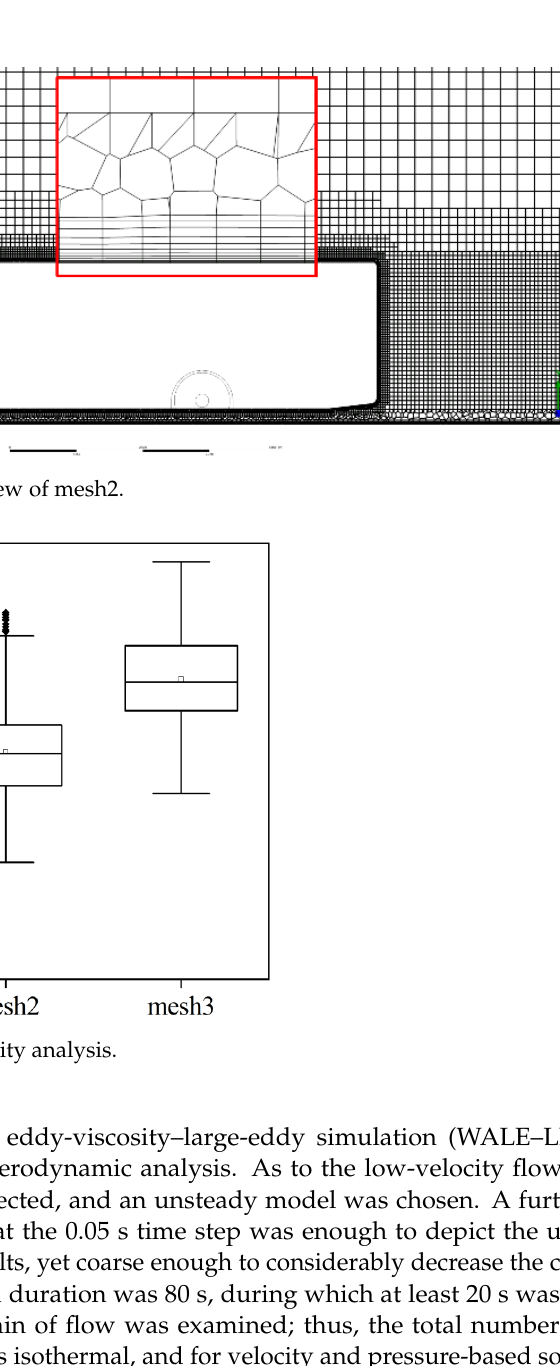
Figure 4. Results of mesh sensitivity analysis.